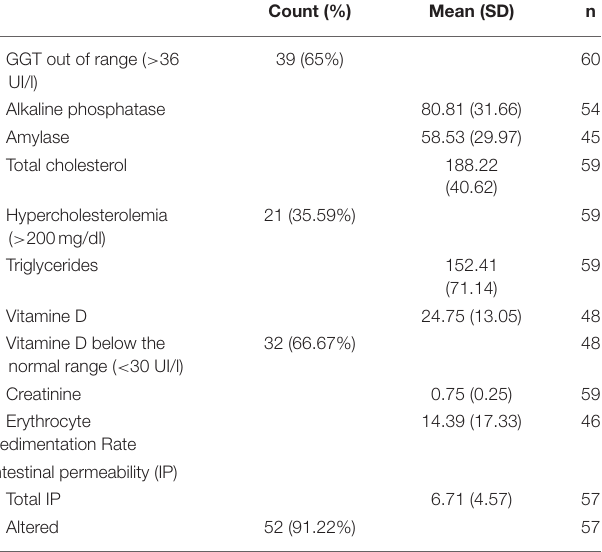
TABLE 1 | Demographic, molecular and clinical characteristics of the cohort of